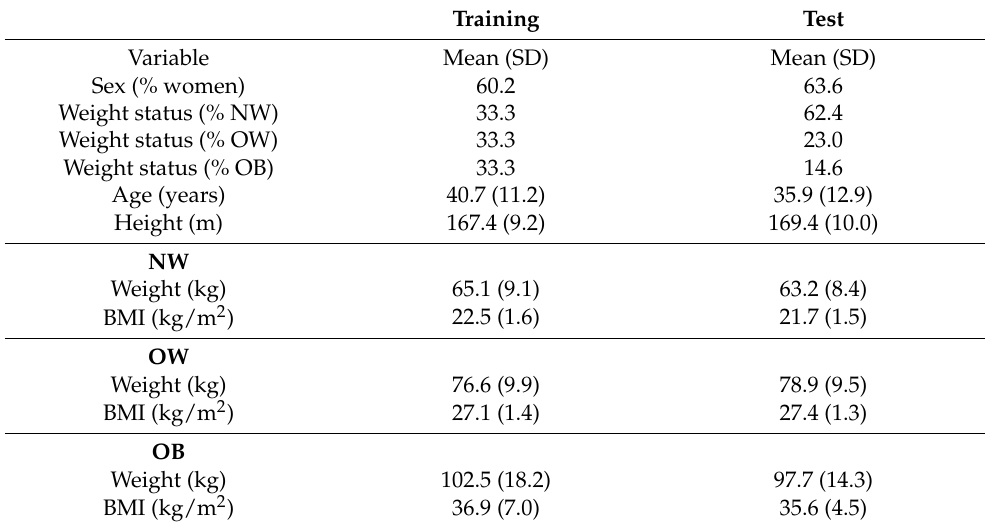
Table 1. Characteristics of both training and test groups. (Mean values and standard deviations (SD)). Training